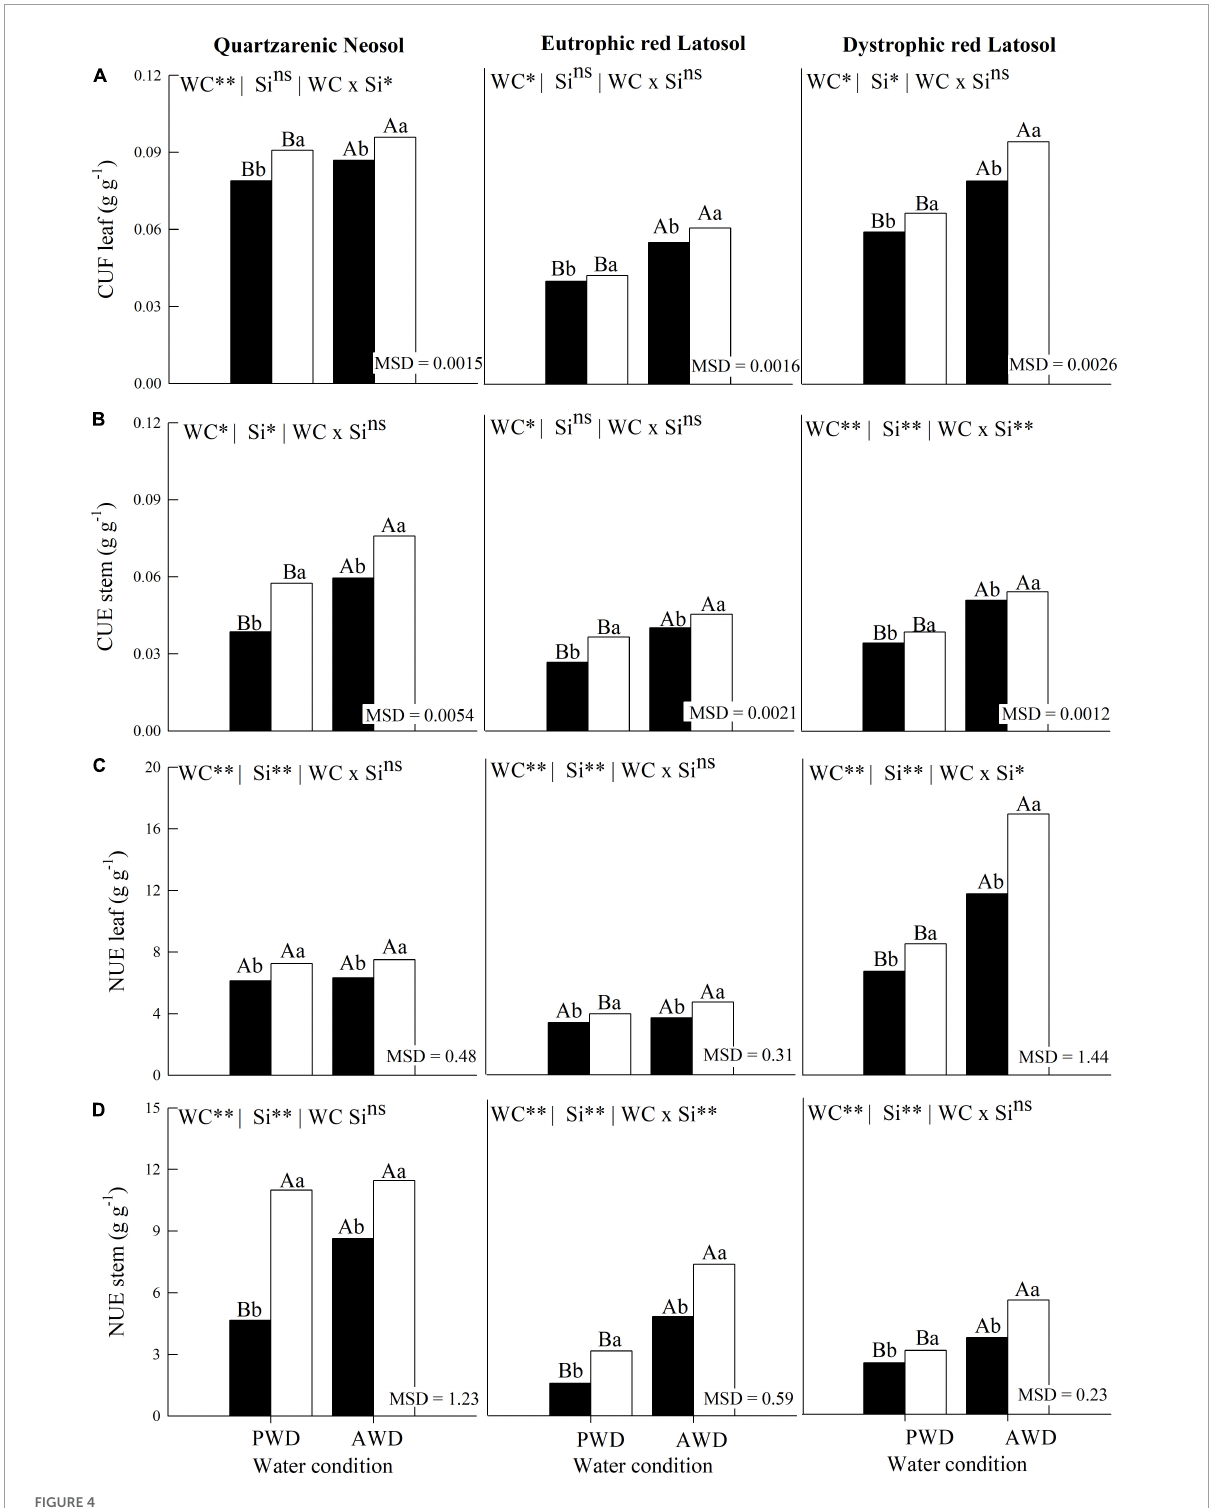
FIGURE4 Use efficiencies of Carbon (A,B) and Nitrogen (C,D) in leaves and stems of sugarcane cultivated with absence (0.0 mM) and presence of fertigated Si (1.8 mM) and two water conditions (without—AWD and with water deficit—PWD) in three tropical soils (Quartzarenic Neosol; Eutroferric Red Latosol; and Dystrophic Red Latosol. CUE, C use efficiency; NUE, N use efficiency; WC, water condition; MSD, minimum significant difference; ** and *: significant at 1 and 5% probability, respectively; NS, not significant at 5% probability. Different uppercase letters indicate differences in water conditions and different lowercase letters indicate differences in Si fertigation by Tukey’s test ( p <